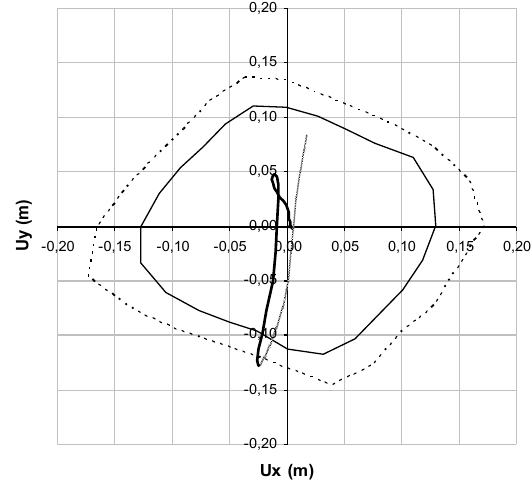
Figure 9. Dynamic analyses results, in plan orientation of the benchmark structure 105°, NDP collapse amplification factor